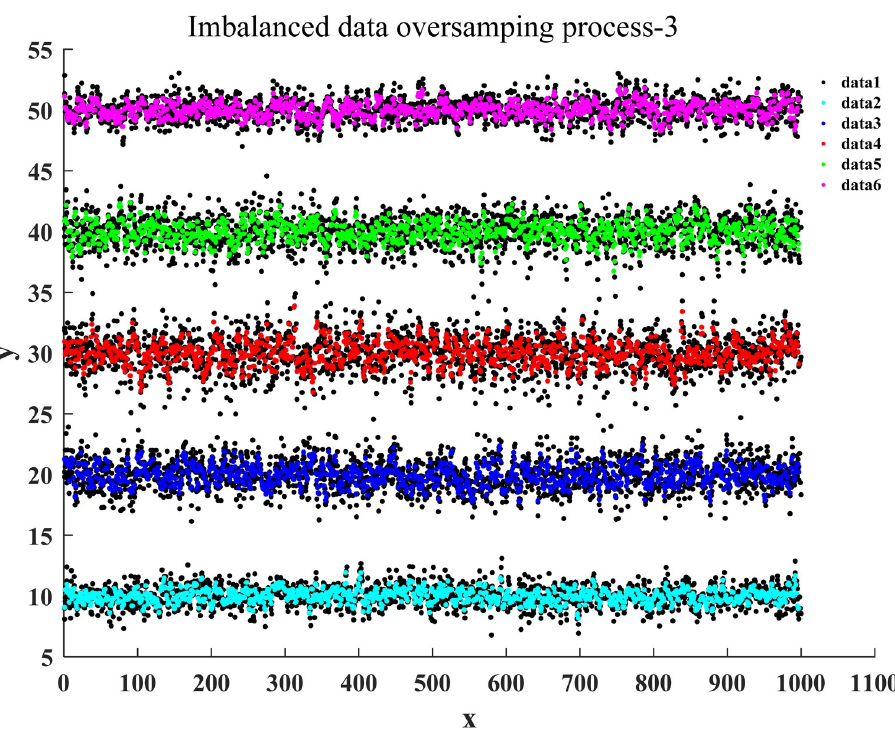
Fig 6. The 3-point sampling of oversampling for imbalanced data. https://doi.org/10.1371/journal.pone.0259227.g006 PLOS ONE | https://doi.org/10.1371/journal.pone.0259227 November12,